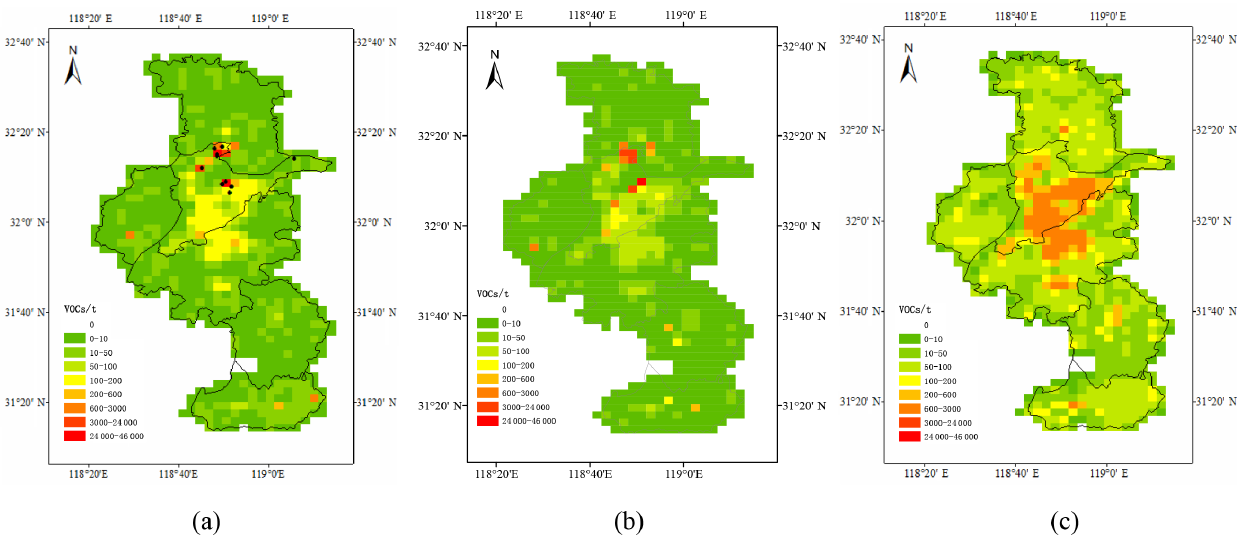
Figure 5. Spatial distributions of NMVOC emissions from the chemical and refinery industries for Nanjing 2011 (3 × 3km), estimated using the detailed enterprise information (a) , environmental statistics (b) and economic statistics without any information on individual sources (c) . The black dots indicate the largest 10 emitters in the city